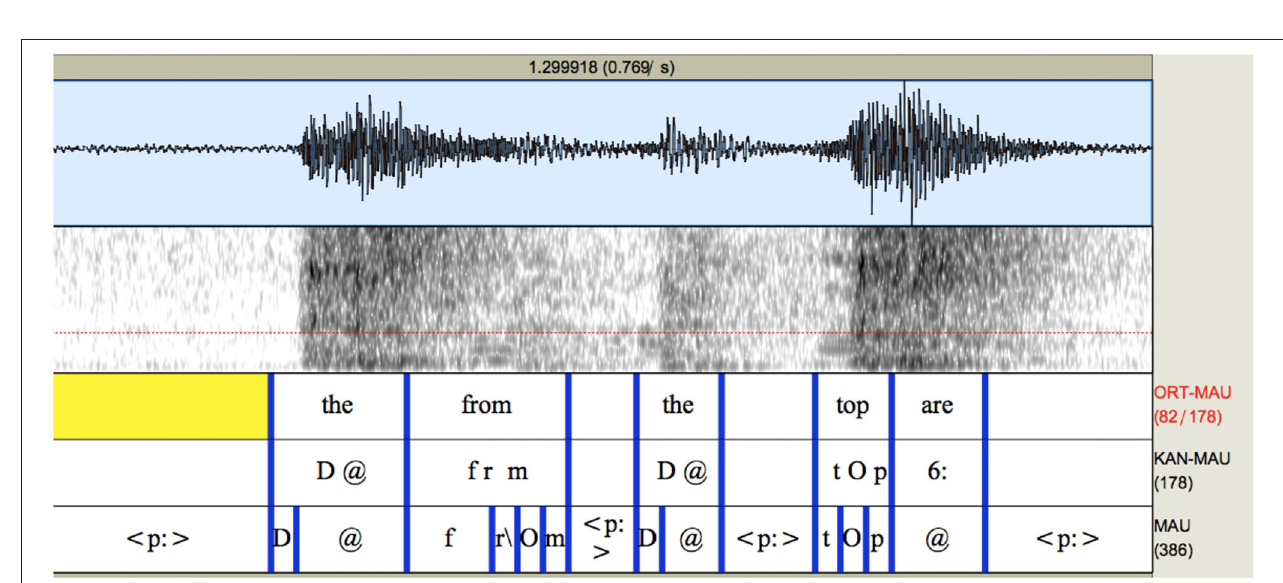
FIGURE 3 | Example 1 of system output with the poor quality recording using WEBMINNI, forced-alignment.